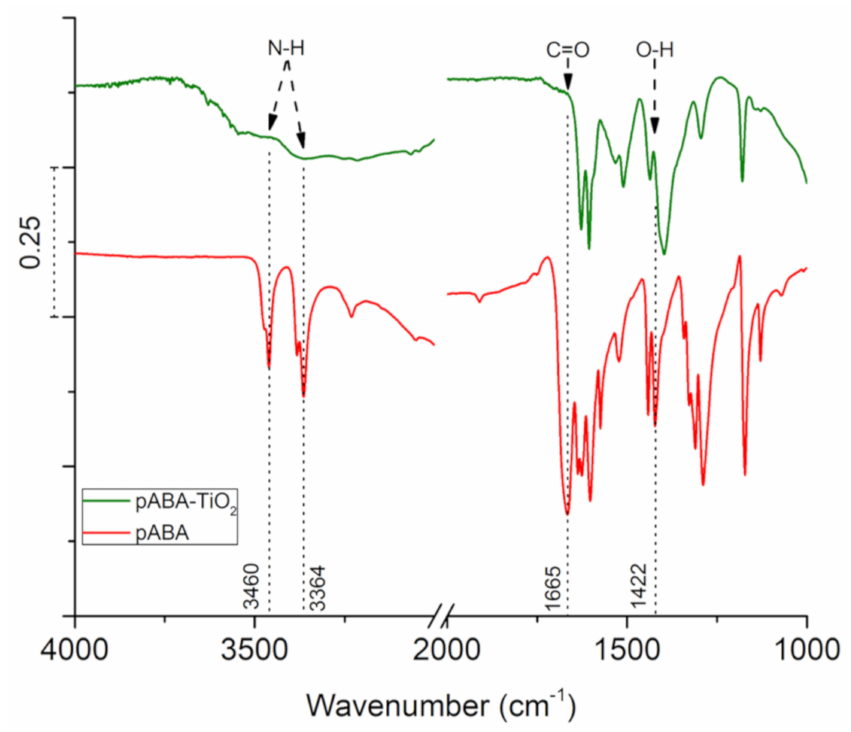
Figure 5. FTIR spectra of pABA (red trace), and pABA-TiO 2 (green trace).